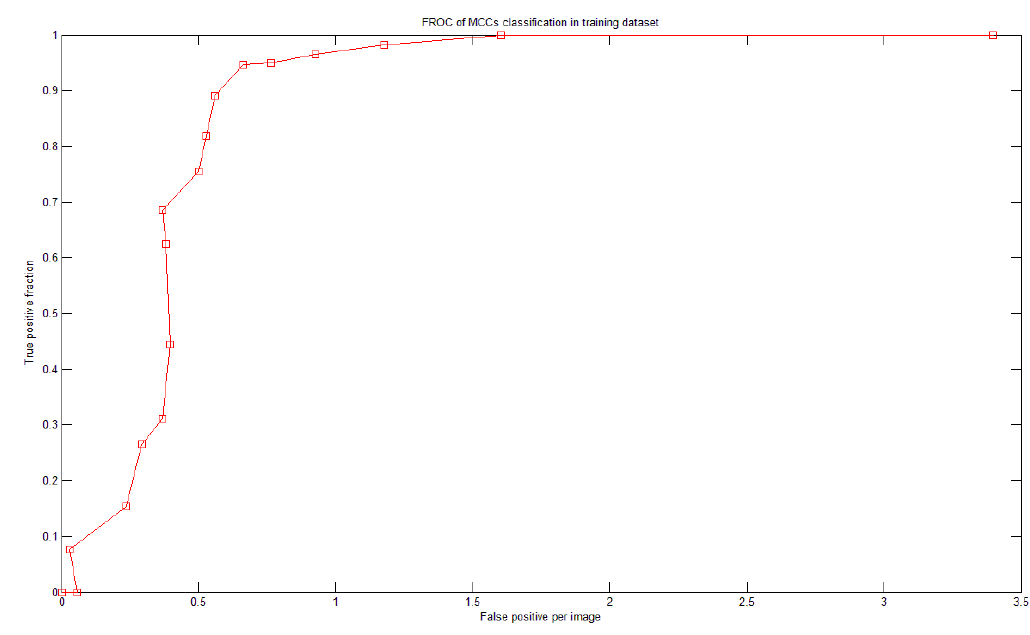
Figure 10. The fROC curve for the training